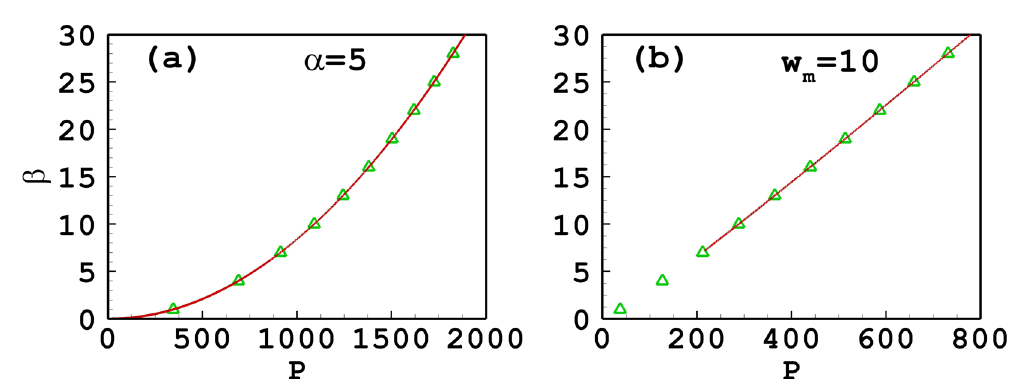
Figure 3. Profiles of the tripole-mode soliton with different soliton powers and propagation constants. The solid line and the dashed line denote, respectively, the approximate solutions and the numerical ones. Parameter w m = 10 for all cases.